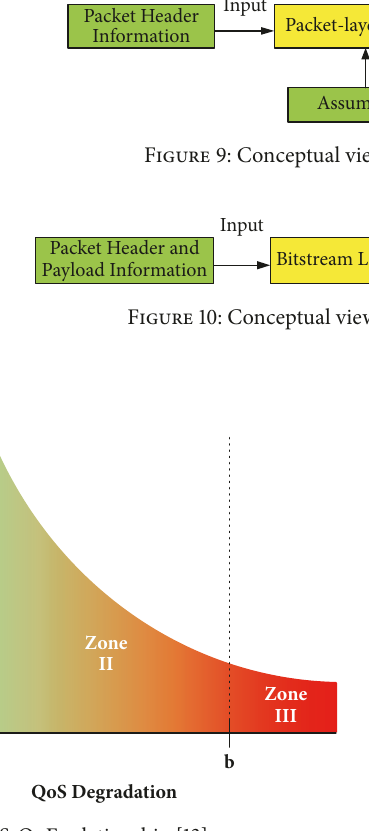
Figure 11: QoS-QoE relationship